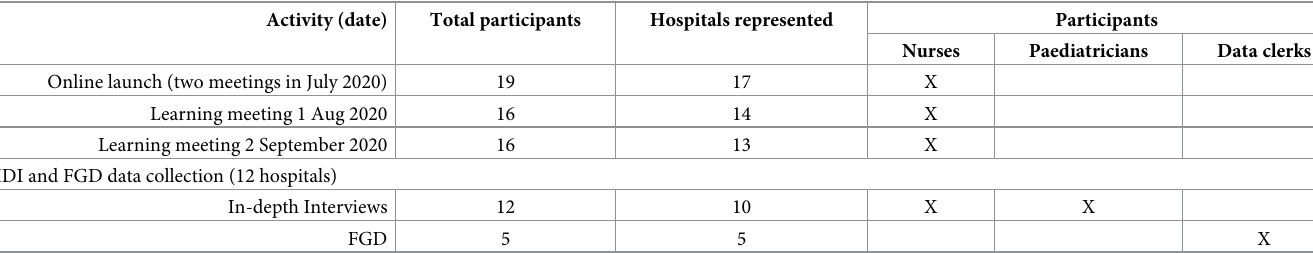
Table 1. Overview of data collection.